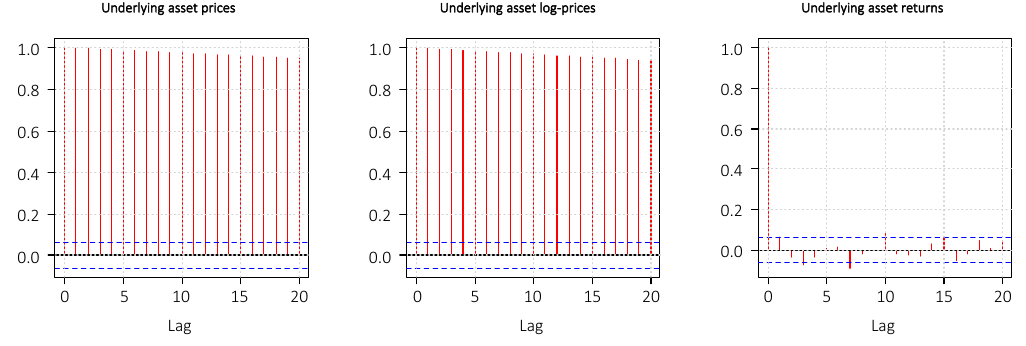
Figure 1. Autocorrelation functions of the CAC 40 index price, log-price and log-return (12/31/1987 –